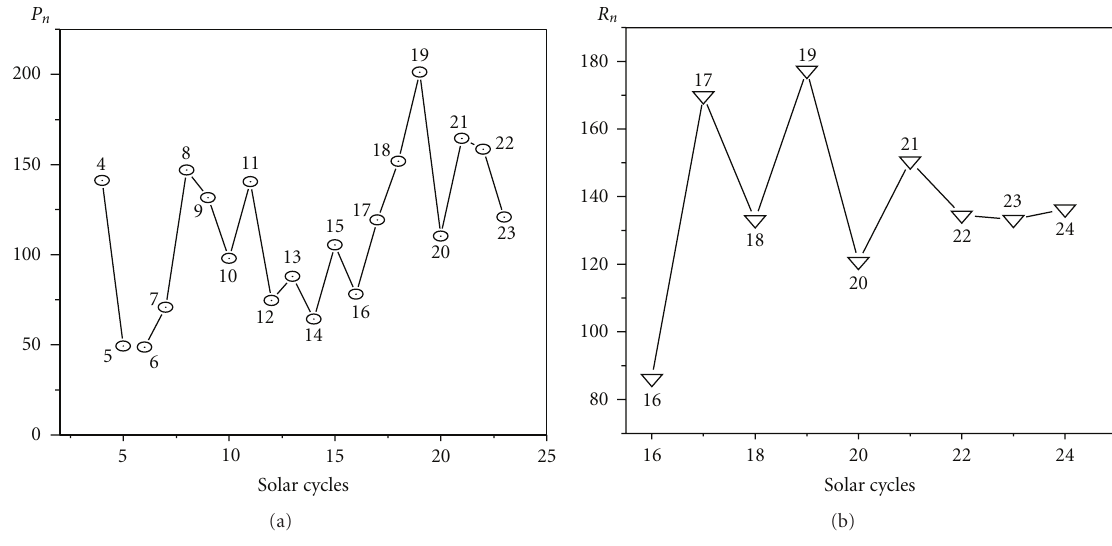
Figure 2: (a) Solar cycle amplitudes from cycle 4 to cycle 23 used to calculate the R n . The filled circles are the observed sunspots ( P n ), and (b) Solar cycle peaks from cycles 16 to 24 as they are estimated. The filled triangles are the predicted sunspots ( R n ).